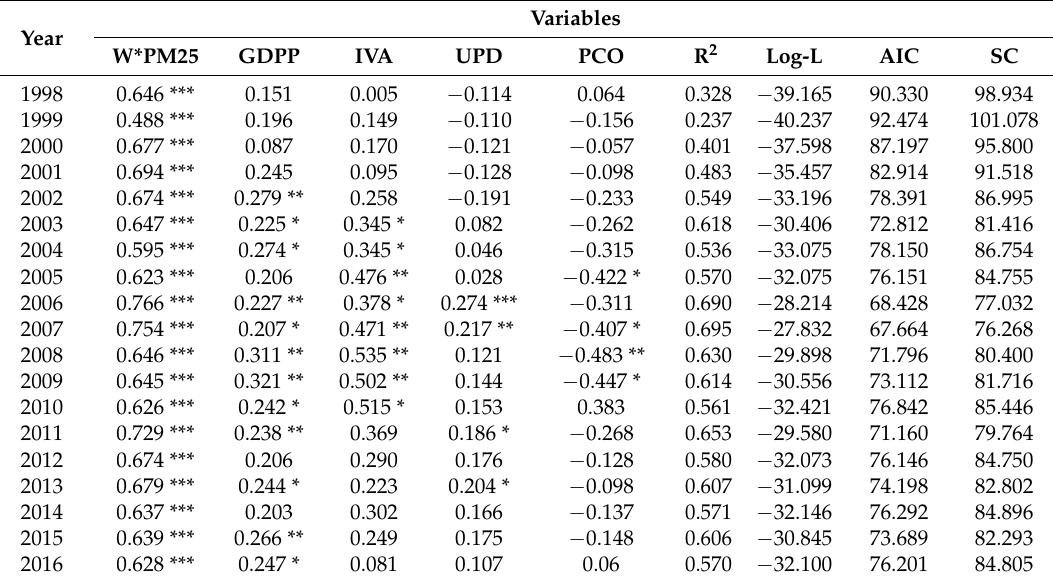
Table 4. The results of spatial lag model regression in